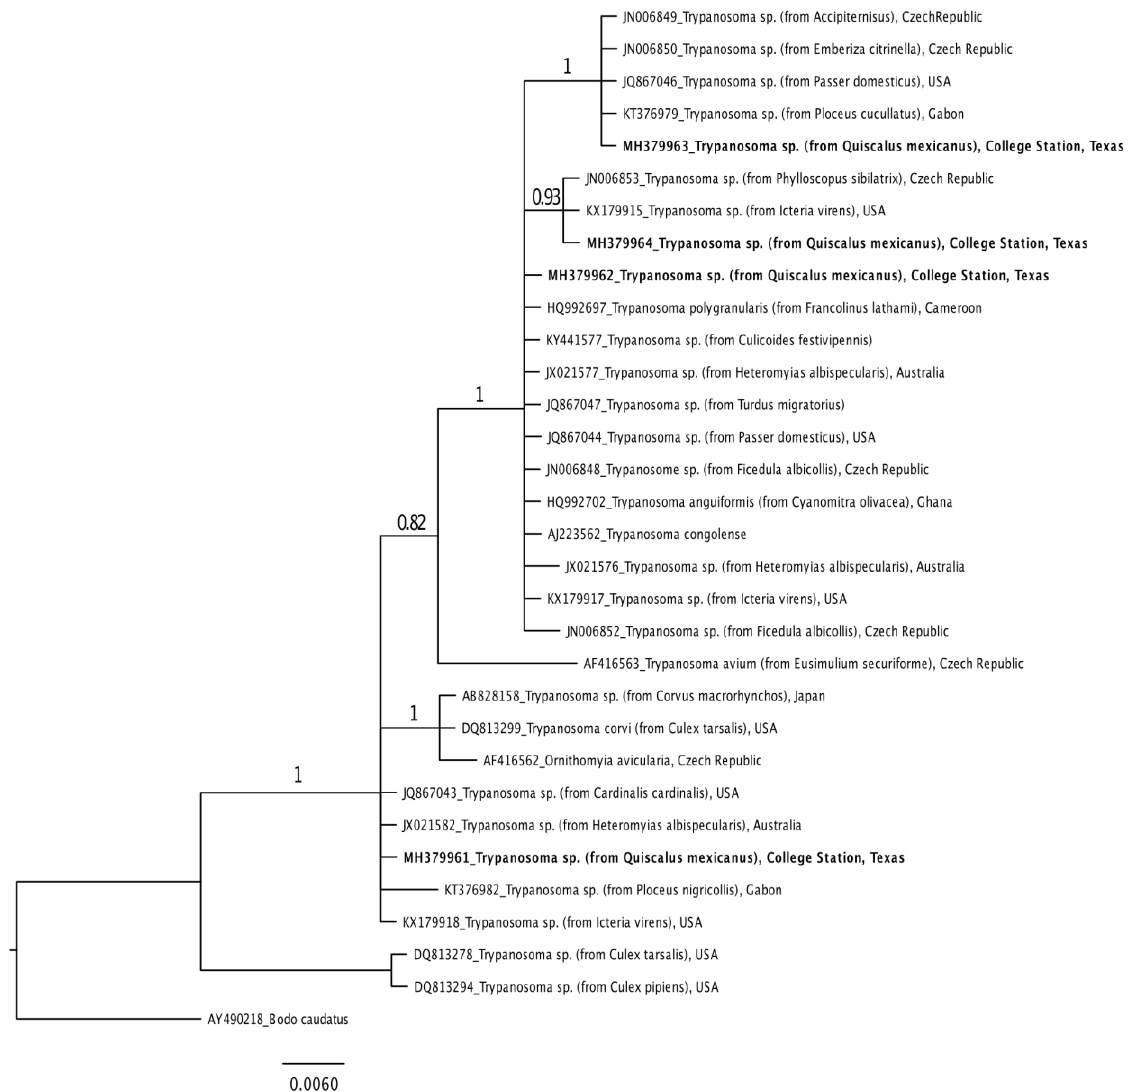
Figure 2. A phylogenetic tree inferred from 219 base pairs of trypanosome 18S RNA gene sequences for 32 taxa with Bodo caudatus (GenBank: AY490218.1) as an outgroup. Trypanosome sequences from great-tailed grackles captured in College Station, Texas are listed in bold font.